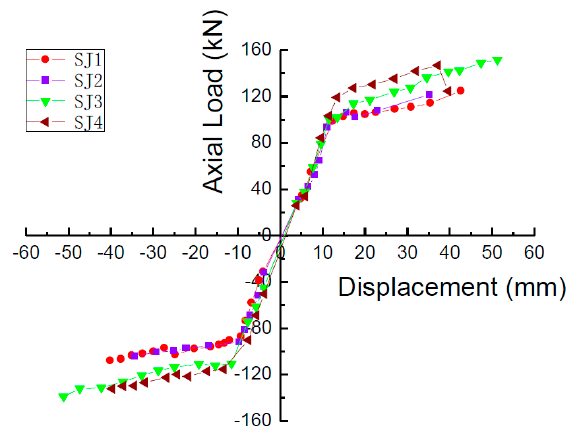
Figure 11. Skeleton curves of the specimens.